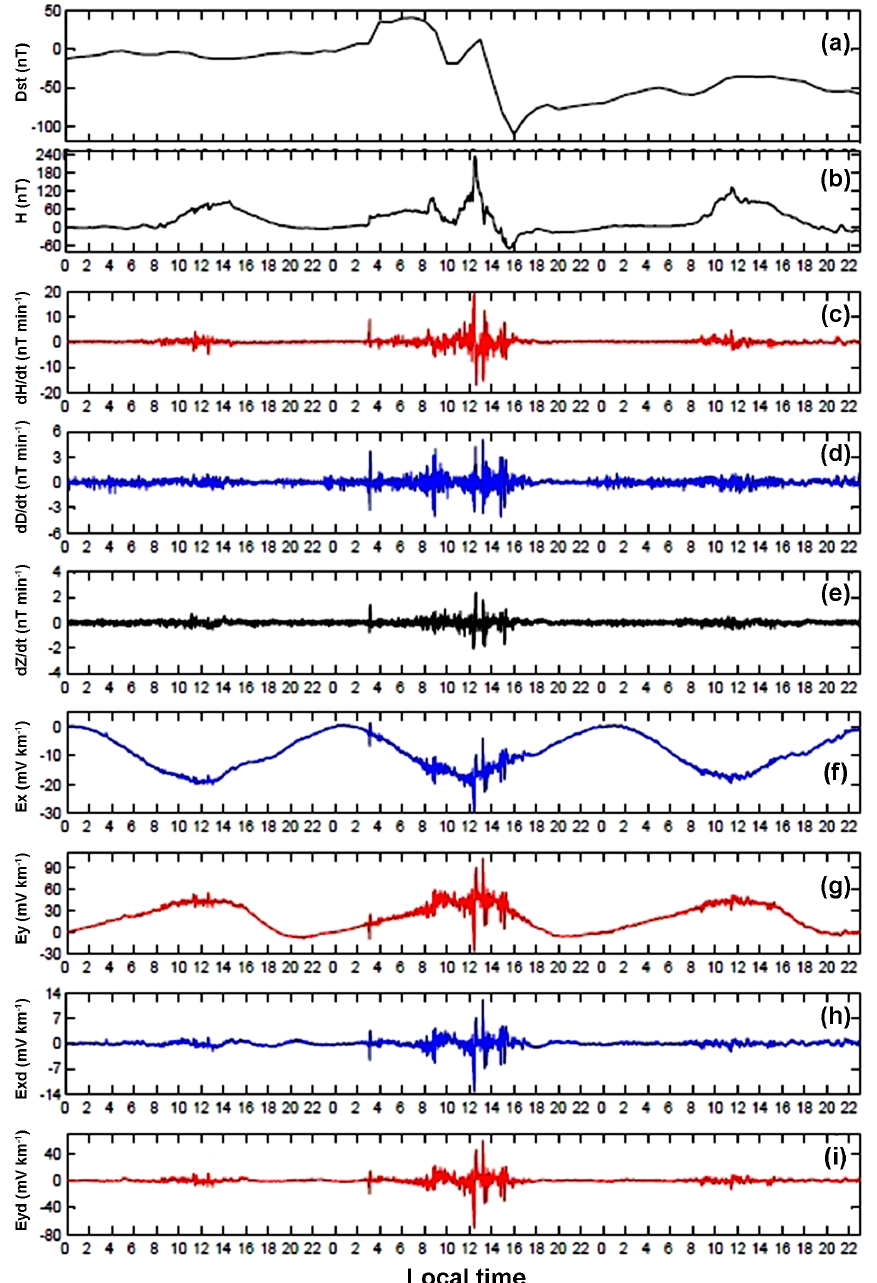
Figure 5. The geomagnetic disturbance effects observed on 16–18 February 1993 at SIK (0.12 ◦ dip lat). Dst index (a) , variations in H (b) , the time derivatives d H/ d t (c) , d D/ d t (d) and d Z/ d t (e) , total variations in the E x (f) and E y (g) component of the geo-electric field,